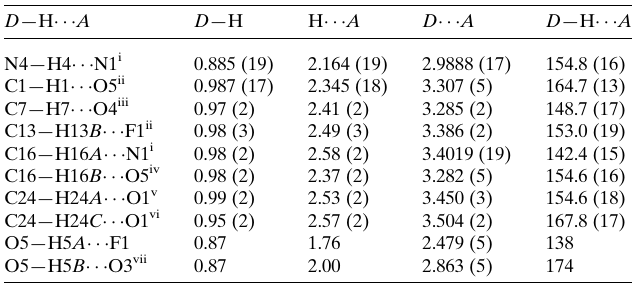
Table 1 Hydrogen-bond geometry (A˚ , (cid:3) ).